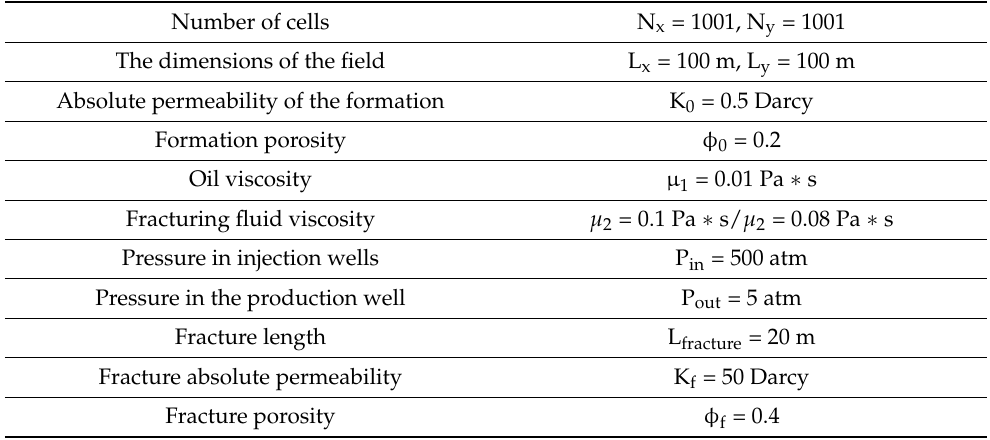
Table 4. Calculation parameters for the second numerical experiment with different fracture fluid viscosities.